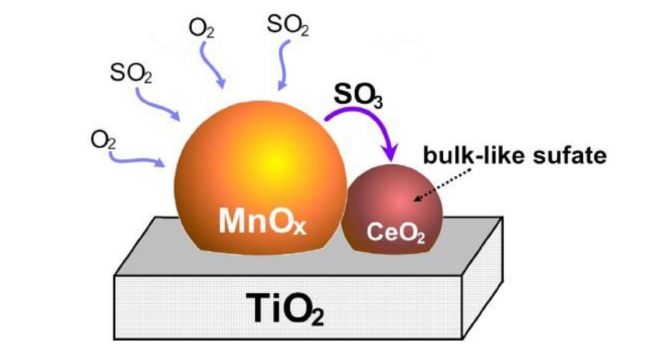
Figure 4. The sulfation mechanism of Ce-modified Mn–Ce / TiO 2 catalyst